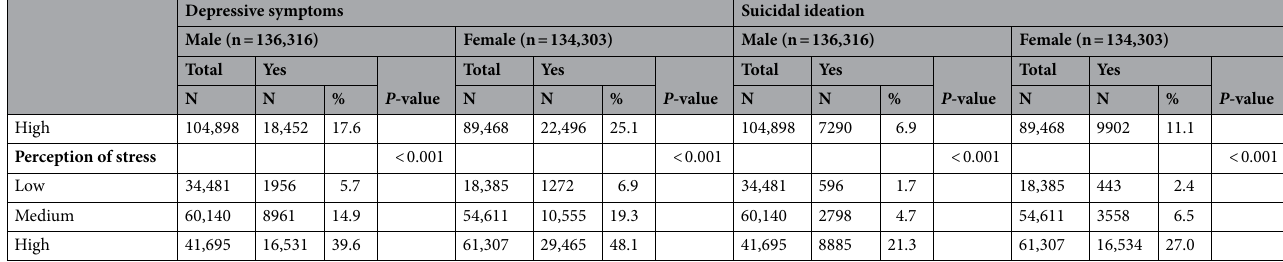
Table 1. General characteristics of the participants. a Weekend sleep duration/weekday sleep duration. b Average sleep duration of weekday and